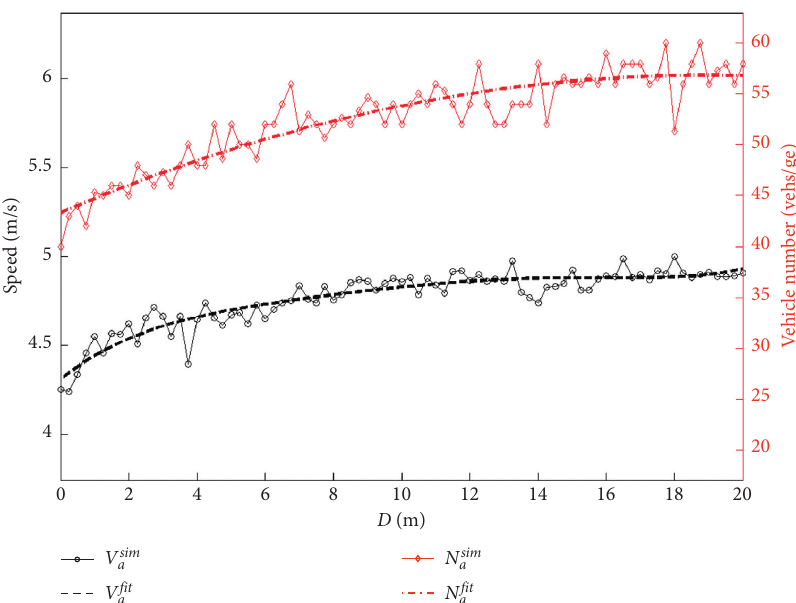
Figure 6: Diagrams under different D of the straddling work zone intersection.